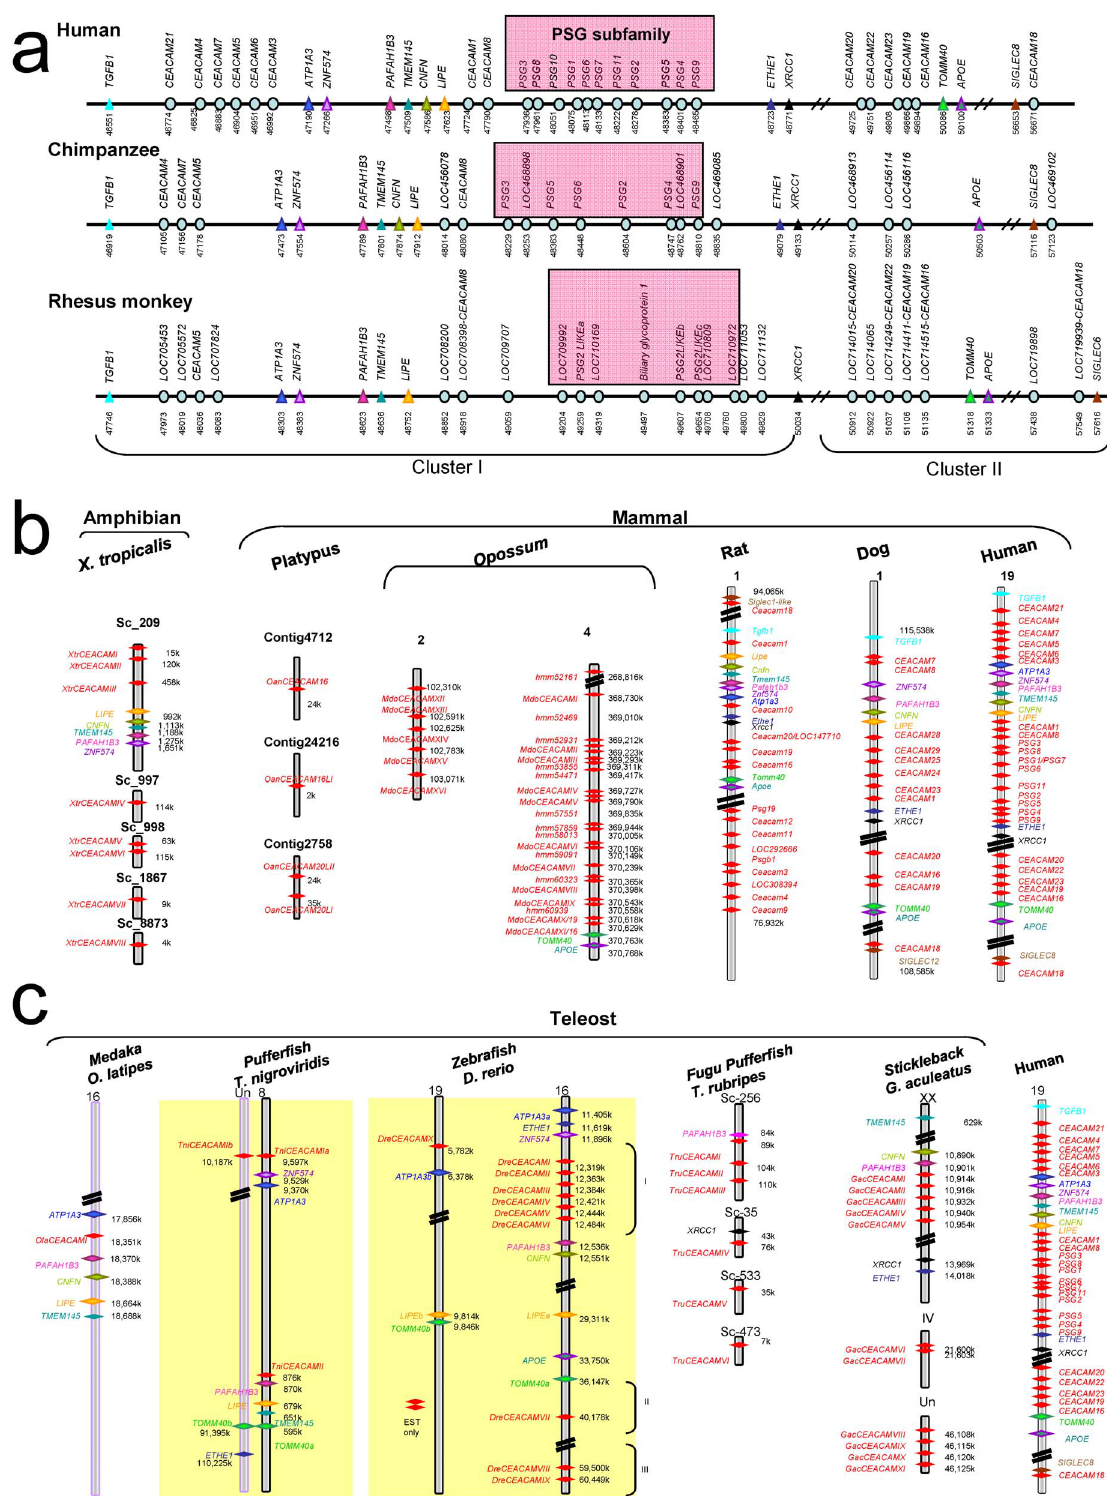
Figure 1. Syntenic mapping of CEACAM/PSG family genes in vertebrates. a) Syntenic mapping of the CEACAM/PSG locus in human, chimpanzee ( P. troglodytes ), and Rhesus monkey ( M. mulatta ). CEACAM/PSG genes of these primates can be subdivided into two clusters: cluster I genes are flanked by orthologs of TGFB1 and XRCC1 whereas cluster II genes are close to orthologs of TOMM40, APOE , and SIGLEC 8. All CEACAM subfamily genes are indicated by blue oval symbols. CEACAM/PSG locus marker genes, including TGFB1, ATP1A3, ZNF574, PAFAH1B3, TMEM145, CNFN, LIPE, ETHE1, XRCC1, TOMM40, APOE, and SIGLEC8, are indicated by triangle symbols. The PSG subfamily genes are indicated by shaded square boxes. The relative position of genes is shown under gene symbols in Kbp. b) Syntenic mapping of CEACAM family genes in dog, rat, the gray short- tailed opossum ( M. domestica ), platypus ( O. anatinus ), and the clawed frog ( X. tropicalis ). The opossum contains more than three dozen paralogs on